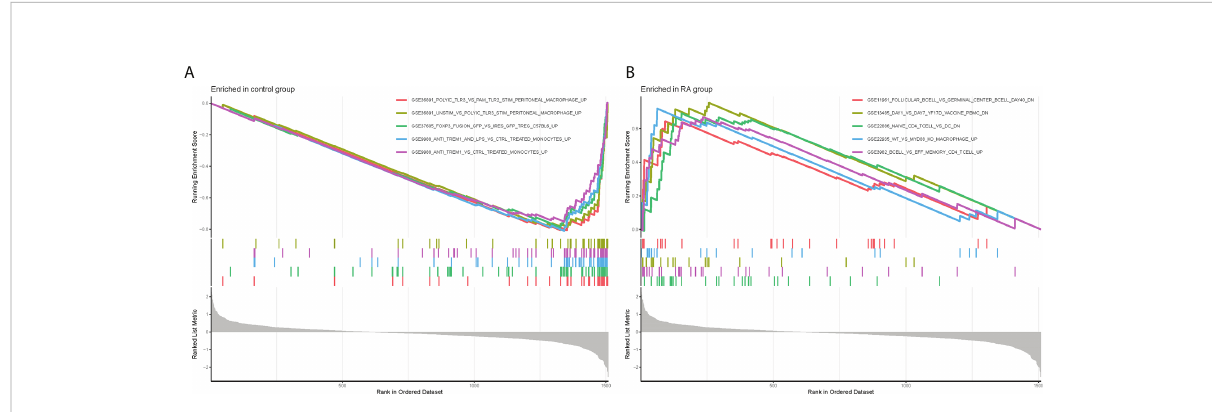
FIGURE 4 Gene Set Enrichment Analysis plots. The fi ve signi fi cant enriched gene sets in the control group (A) and RA group (B) .